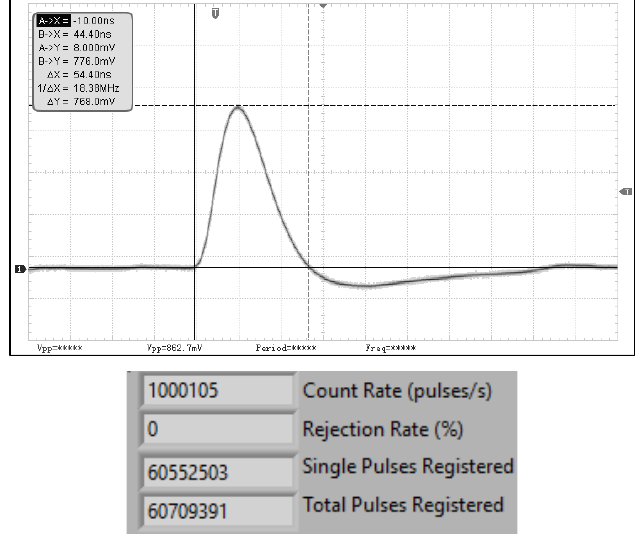
Fig. 11. The test signal and the registered count